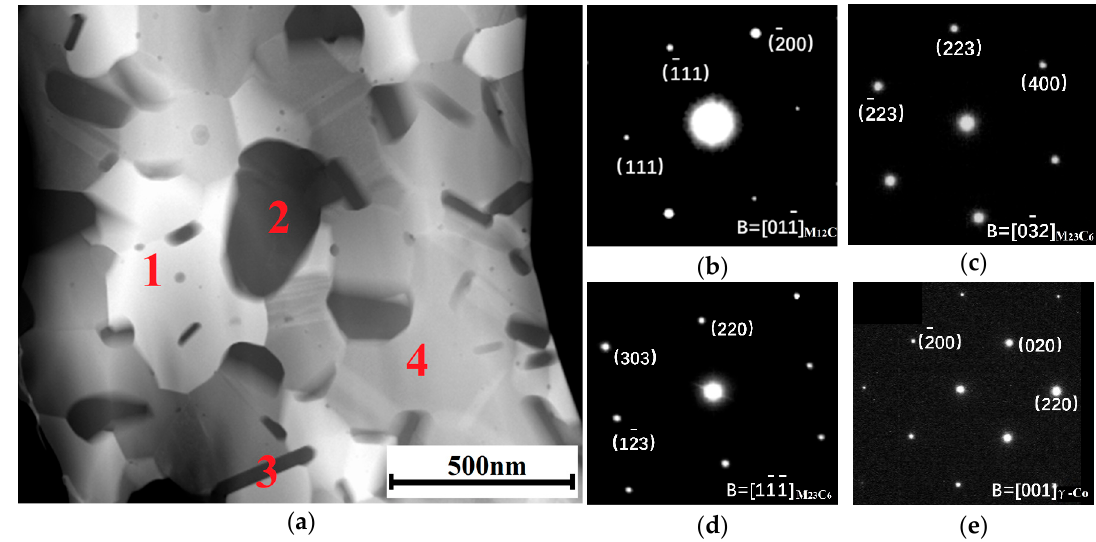
Figure 5. STEM high-angle annular dark field (HAADF) image of the obtained bulk cobalt-based alloy ( a ) and selected area electron diffraction (SAED) patterns of the different phases labeled in ( a ), ( b ) point 1, bright, ( c ) point 2, dark, ( d ) point 3, dark, and ( e ) point 4, grey. Table 1. STEM-EDS results of the phases in the prepared bulk cobalt-based alloy (at. %). Point Cr W Phase